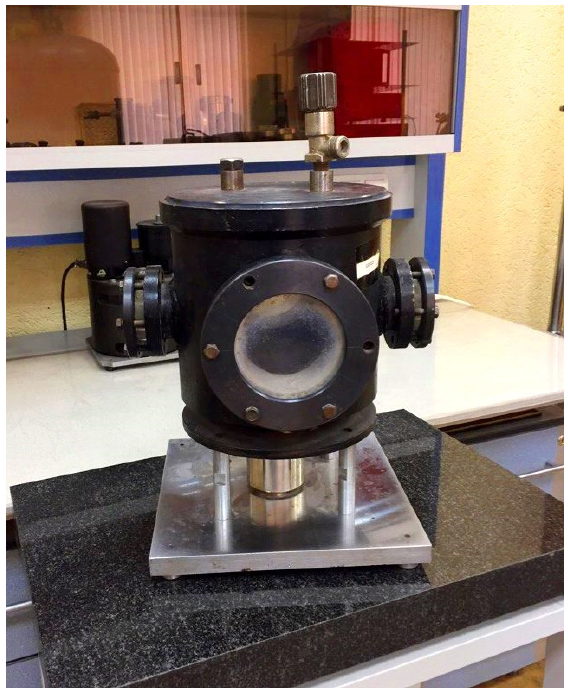
Figure 1. Explosion chamber (photo by the author R.S. Babkin).